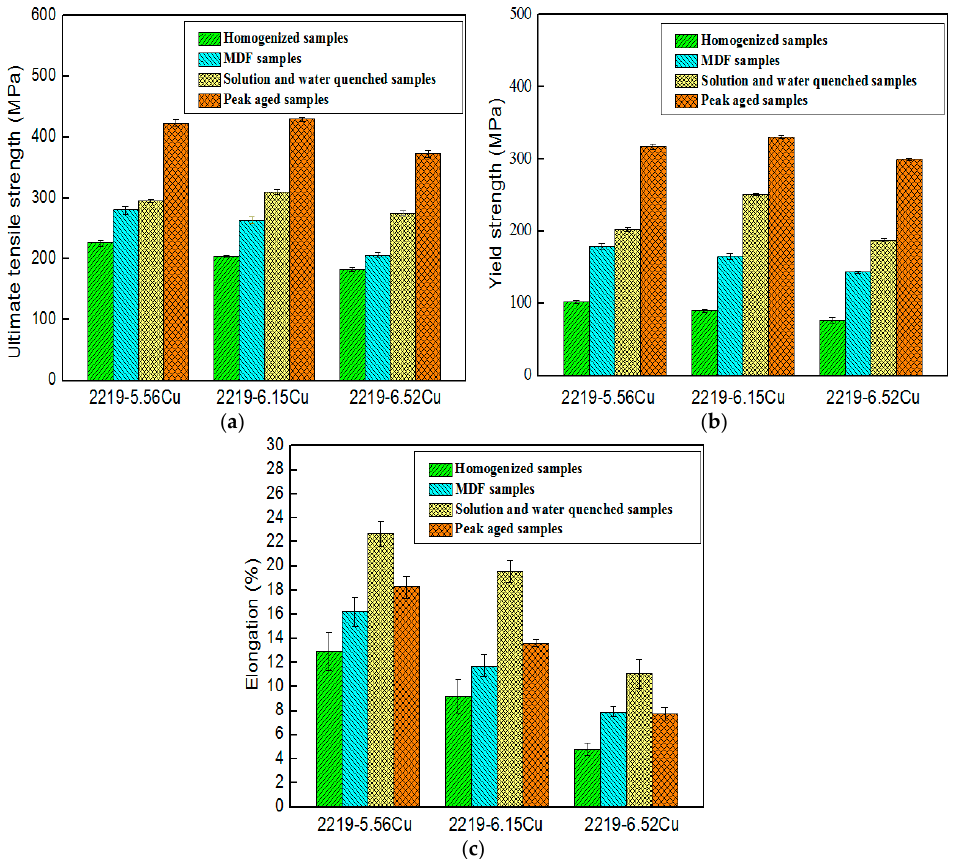
Figure 9. Mechanical properties of 2219 aluminum alloys with different Cu contents: ( a ) The ultimate tensile strength, ( b ) the yield strength, ( c ) elongation.